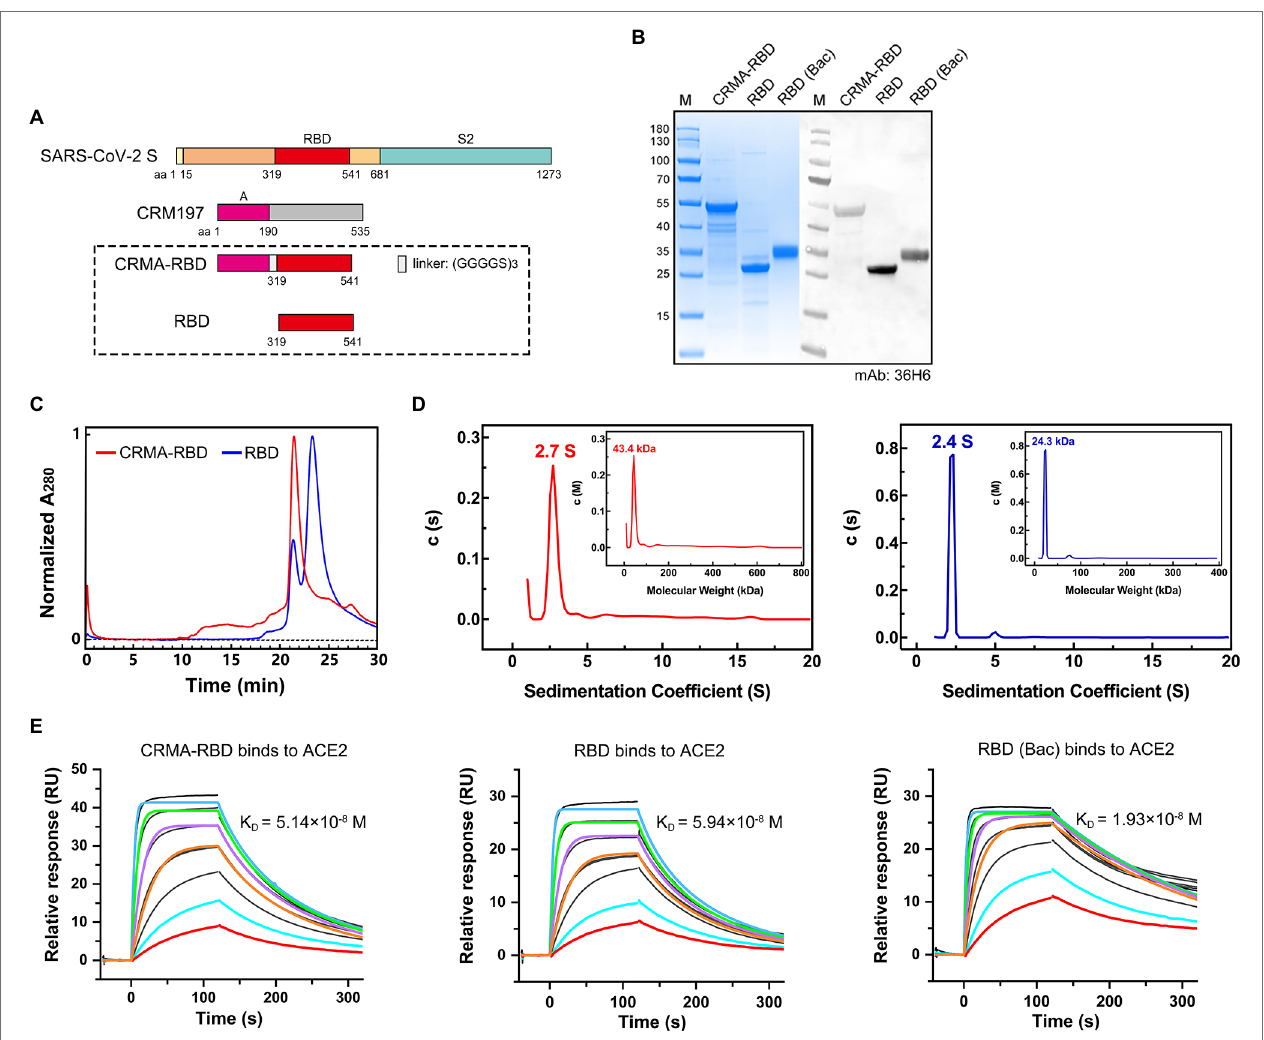
FIGURE 1 | Construct design and characterization of the CRMA-RBD protein. (A) Schematic map of the CRMA-RBD construct design. Fragment A of Cross- Reacting Material 197 (CRM197) was fused to the N-terminus of severe acute respiratory syndrome coronavirus 2 (SARS-CoV-2) RBD via a flexible linker. S, spike protein; CRM197, Cross-Reacting Material 197; and RBD, receptor binding domain. (B) Purified CRMA-RBD and RBD analyzed by SDS-PAGE and western blotting. Bac: Baculovirus expression vector system. RBD (Bac), recombinant RBD protein from Baculovirus insect cell expression. M: Marker. (C) Purified CRMA- RBD and RBD proteins were evaluated by high-performance size-exclusion chromatography (HPSEC). (D) Purified CRMA-RBD and RBD proteins were analyzed by analytical ultracentrifugation (AUC). CRMA-RBD is shown in red, and RBD is shown in blue. Sedimentation coefficients of CRMA-RBD and RBD were determined by sedimentation velocity (SV) tests; molecular weights of CRMA-RBD and RBD in solution were evaluated by the c (M) method. (E) Analysis of CRMA-RBD (left), RBD (middle), and RBD (Bac; right) binding to the ACE2 receptor protein by surface plasmon resonance technology